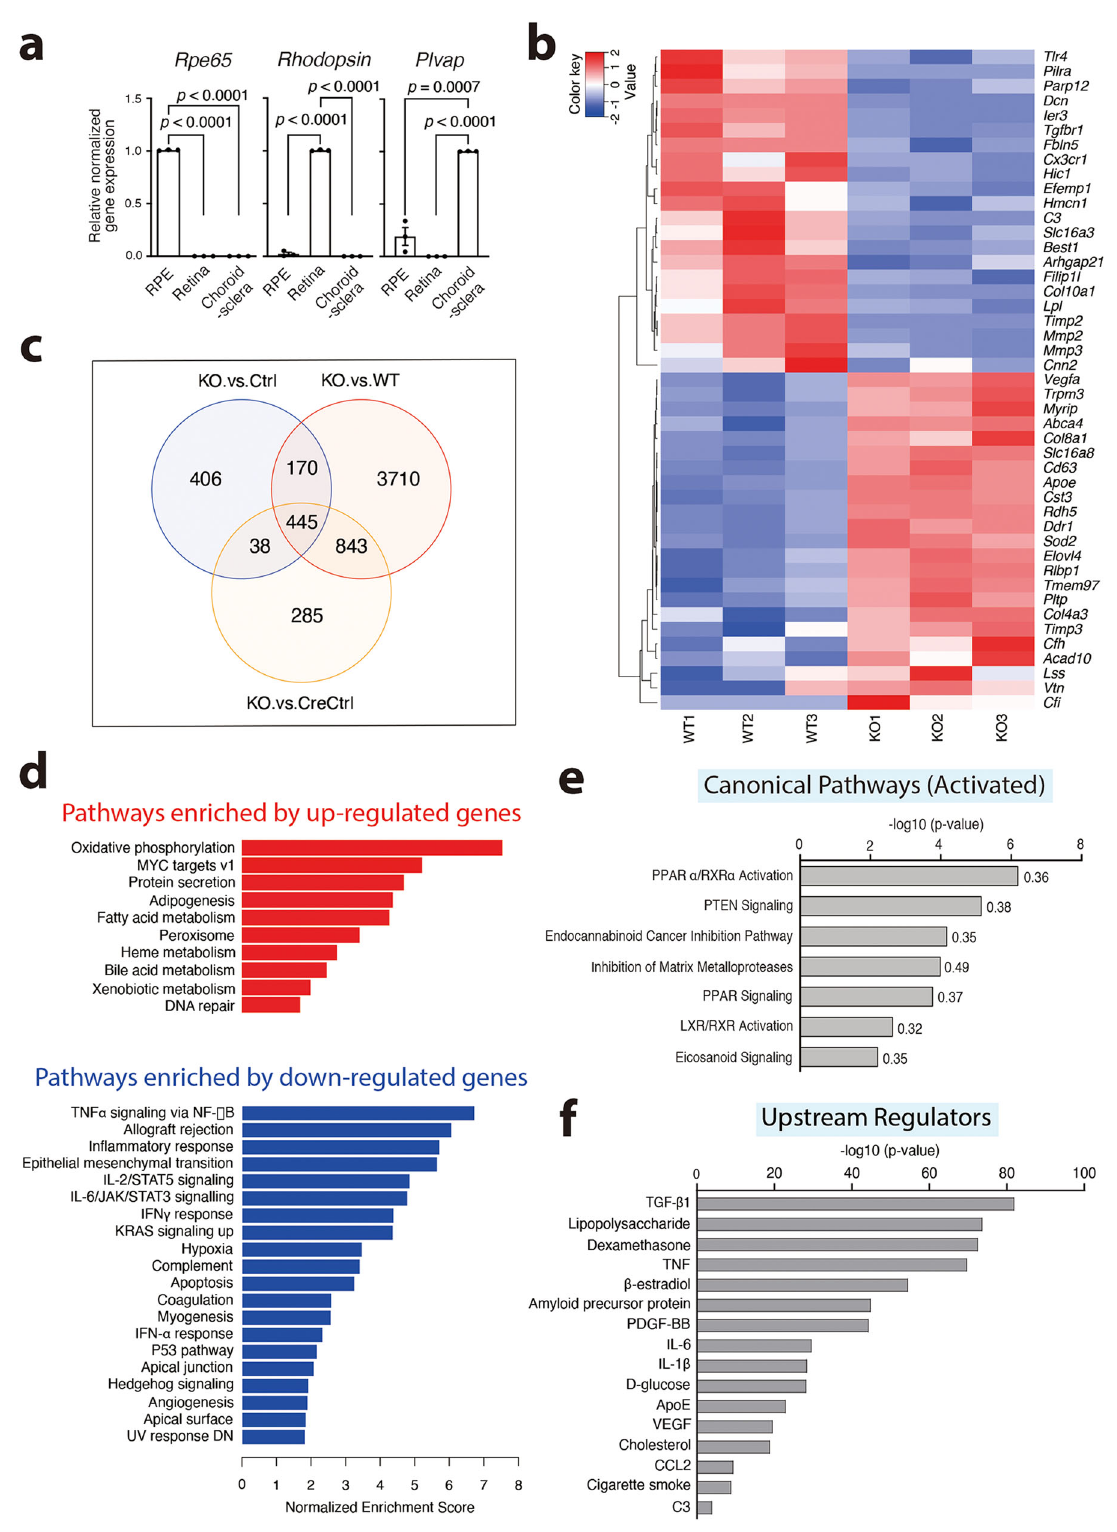
Fig. 4 CLIC4 de fi ciency causes transcriptomic reprograming and pathway changes in RPE cells. a Tissue-speci fi c RNA enrichment. qPCR results of the indicated genes (Rho: rhodopsin) using RNAs isolated from RPE, retina, or choroid-sclera cups of WT mice as templates. Data are shown as means ± SEM of n = 3 biologically independent experiments. Two-tailed Student ’ s t -test. b The heat map depicts the AMD risk genes whose expression level was signi fi cantly different between the KO and WT mouse RPE cells ( n = 3 independent experiments). c Venn diagrams showing the numbers of three sets of DEGs (FDR < 0.05) from comparisons of KO vs. WT, Ctrl, and CreCtrl. d GSEA identi fi ed 30 signi fi cant Hallmark pathways (FDR < 0.05) in which 10 were upregulated and 20 were downregulated. These pathways were shared by all three groups (KO vs. WT, Cre, CreCtrl). The absolute normalized enrichment scores from the comparison KO vs. CreCtrl are shown. e , f Examples of IPA-identi fi ed enriched activated canonical pathways ( e ) and upstream regulators ( f ). The P -values ( e , f ) and the ratios ( e ) from the KO vs. WT group are shown. Source data of ( a , b ) are provided as a Source Data fi